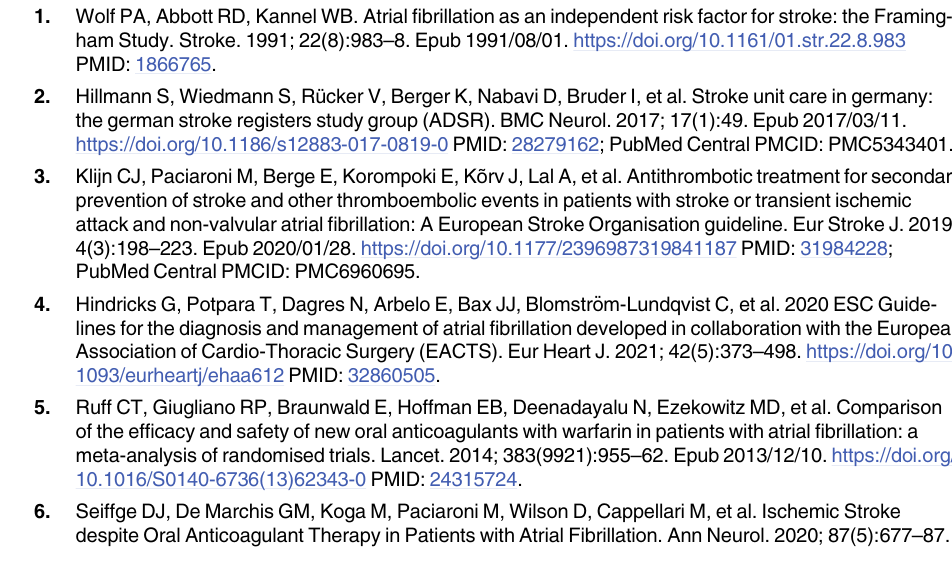
S1 Table. Preferences in switching oral anticoagulation (OAC) in different settings with respect to regional versus trans-regional stroke units